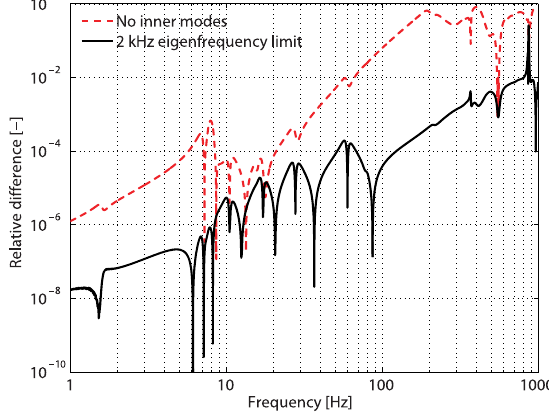
Fig. 13. Vibro-acoustic response (total translation displacement of the coupling interface between part 1 and 2). All inner modes included (solid line) and no inner modes included (dashed line).